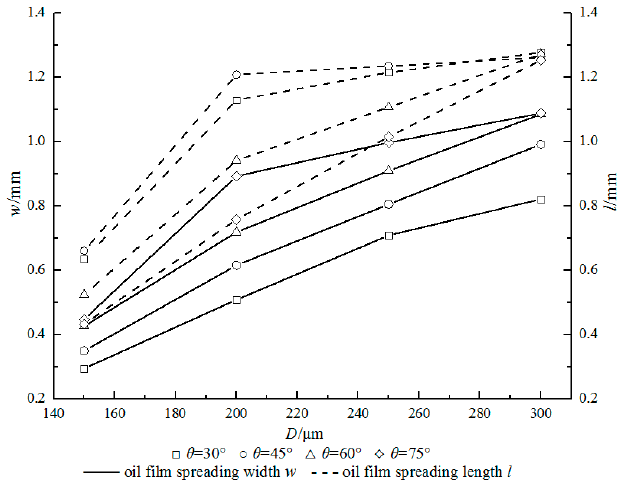
Figure 6. Effect of incident angle on spreading characteristics of deposited oil film when the impacting velocity is 20 m/s.